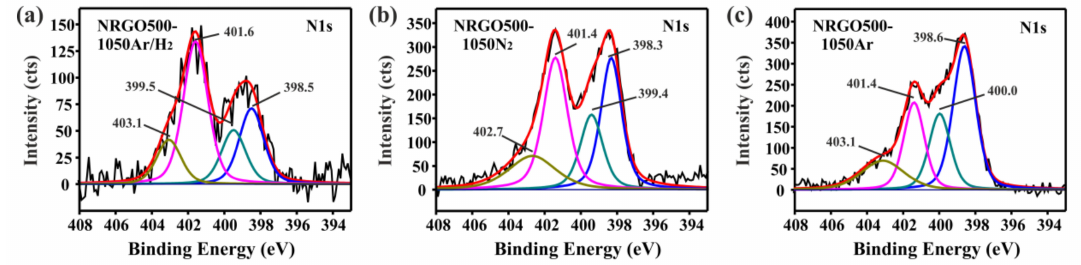
Figure 3. High-resolution N1s spectra of ( a ) NRGO500-1050Ar / H 2 , ( b ) NRGO500-1050N 2 , and ( c ) NRGO500-1050